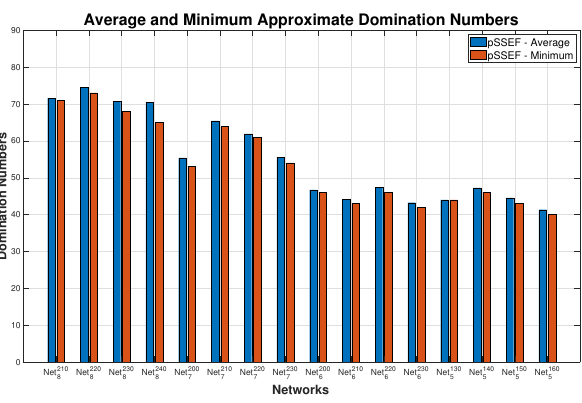
Figure 10. Comparisons between the average and minimum connected domination number of